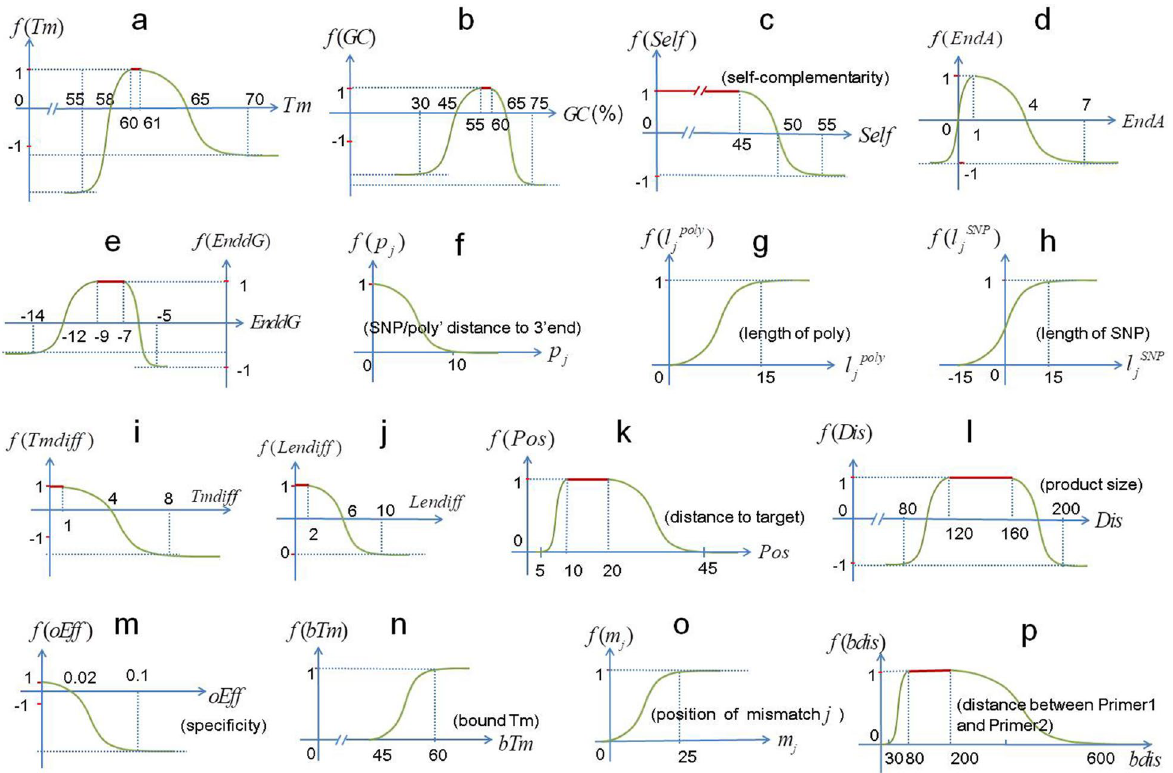
Figure 3. Piecewise logistic model curves of various features. ( a–e ) Score models of Tm, GC, self- complementarity (Self), As on the 3 ′ end (EndA), and free energy of the 3 ′ end (EnddG) of primers; ( f–h ) Score models of common SNPs and polys; ( f ) is the model of position (distance to the 3 ′ end) of the SNP/poly, ( g,h ) are the models of lengths of a poly and SNP, respectively; ( i–m ) Score models of five relation features between primers in a pair: Tm difference, length difference, the distance of the Primer1 to target (Pos), product size, and specificity, respectively. The x value of specificity is the sum of efficiencies of all non-target products (oEff). ( n–p ) Efficiency prediction models of a non-target product, n is model of the bound Tm of a primer’s non-target alignment, o is model of position (distance to the 3 ′ end) of each mismatch in the primer’s alignment, ( p ) is model of the distance between Primer1 and Primer2 in a non-target